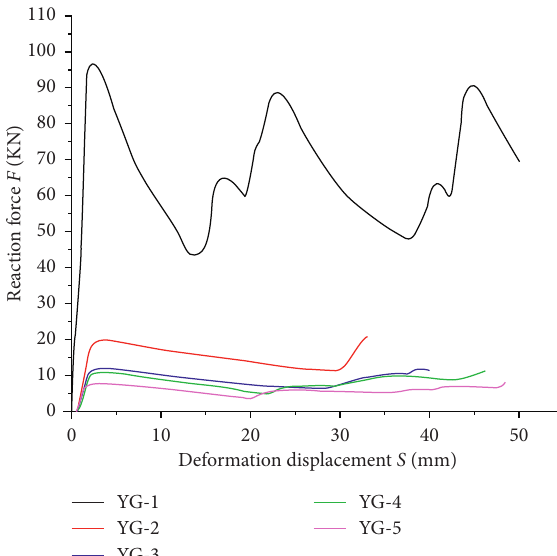
Figure 10: The reaction force-deformation curve of the compression buckling test.